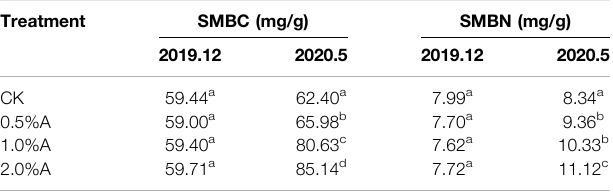
TABLE 3 | Effects of biomass charcoal on soil microbial biomass carbon and nitrogen (SMBC and SMBN, respectively). Treatment SMBC